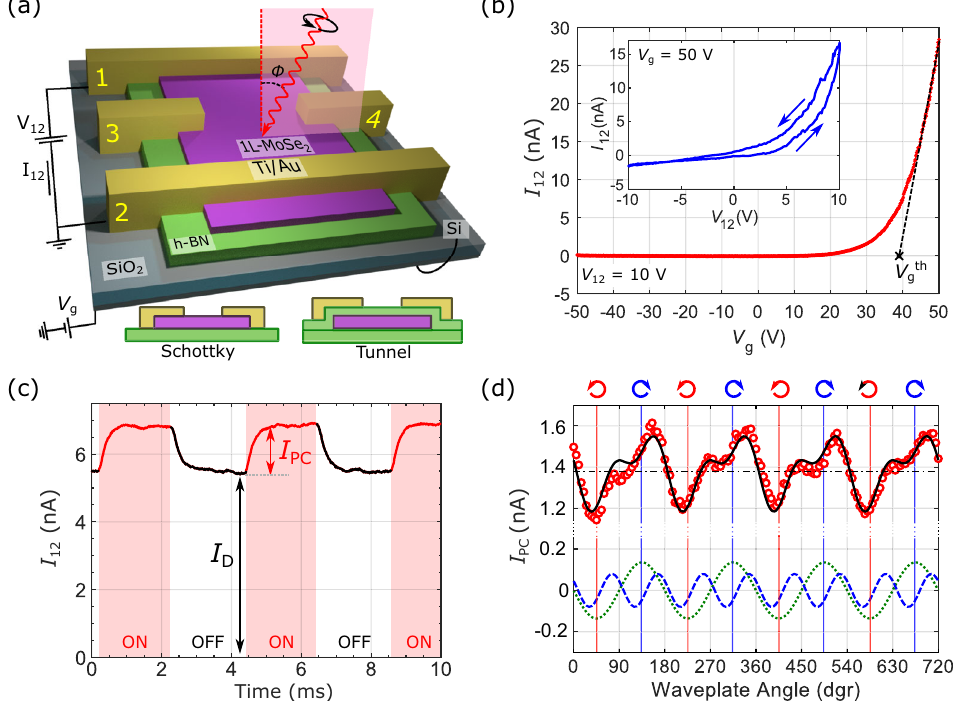
Fig. 1 Device geometry and optoelectronic response. a Schematic of the device with direct metal / 1 L-MoSe 2 contacts and measurement geometry. The optical excitation is achieved by exposing the entire device to a wavelength-tuneable laser source, hitting the sample at an oblique angle of incidence ϕ . The polarization and helicity of the light excitation is selected using a λ /4 waveplate. The bottom diagrams show a side view of the two possible device geometries, either with Ti/Au Schottky contacts fabricated directly on top of the 1L-MoSe 2 /hBN structure (left) or with a top bilayer hBN fl ake acting as tunnel barrier between the 1L-MoSe 2 and the contacts (right). b Two-terminal transfer characteristic of the device for V 12 = 10 V, showing a clear n-type behavior. The threshold gate voltage is found to be around V gth = 40 V. Inset: I – V characteristic measured at V g = 50 V. Arrows indicate scan direction. c Total current I 12 along the device for V 12 = 10 V and V g = 50 V. When the light excitation ( λ = 790 nm) is turned on, the total current along the device increases by I PC = 1.4 nA. d Photocurrent I PC (red circles) as a function of the waveplate rotary angle θ and fi tting to Eq. 1 (black, solid line). The discontinuous lines represent the three separate contributions indicated in Eq. 1, I 0 (black, dash-dotted line), L sin(4 θ + δ ) (blue, dashed line) and C sin(2 θ ) (green, dotted